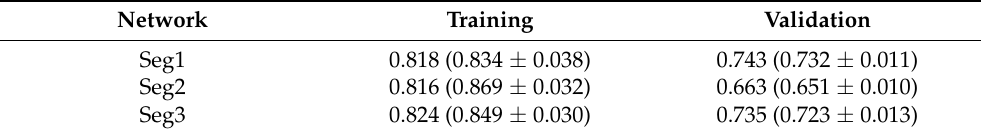
Figure 2. Example core from validation TMA with overlaid heatmap of segmentation (yellow filling); ( a ) original annotations of tumor areas and ( b ) tumor areas defined by segmentation (blue lines: tumor, black lines: normal tissue surrounded by tumor). Table 3. Intersection over union (IoU) for the training and validation of the segmentation networks. Mean IoU and standard deviation of five identical training processes are displayed in brackets. Respective network with the highest validation IoU is